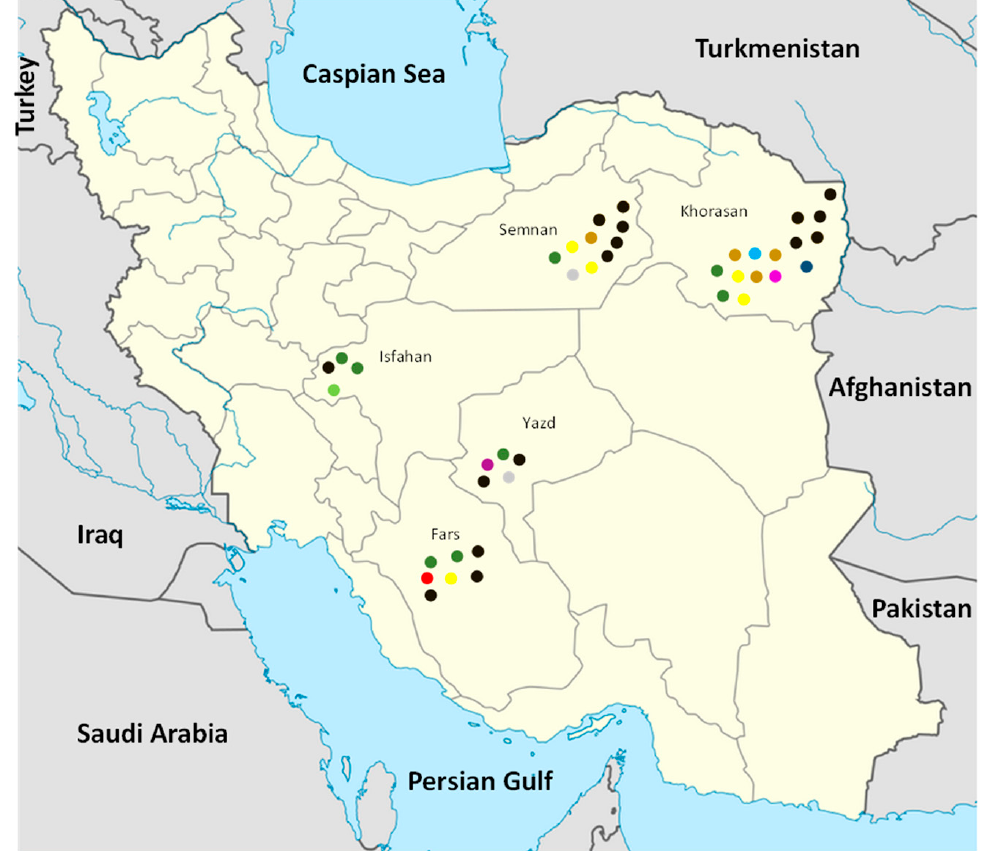
Figure 1. Distribution of FSSC isolates recovered from melons in Iran and examined in this study. Each isolate was recovered from a distinct field. In the map, each dot represents an isolate and each color represents a multilocus haplotype (MH). Dark green: MH 4; Light green: MH 12; Dark blue: MH 2; Yellow: MH 10; Pink: MH 22; Brown: MH 16; Light blue: MH 13; Red: MH 11; Gray: MH 15; Purple: MH 3.